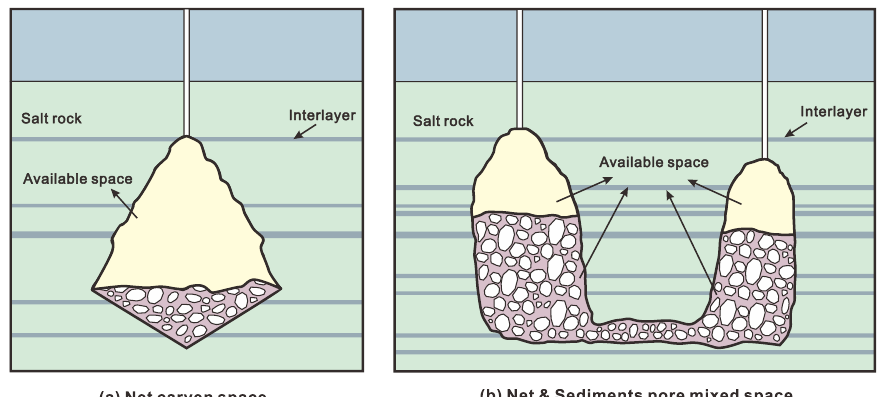
Figure 3. Utilization mode of salt caverns space.